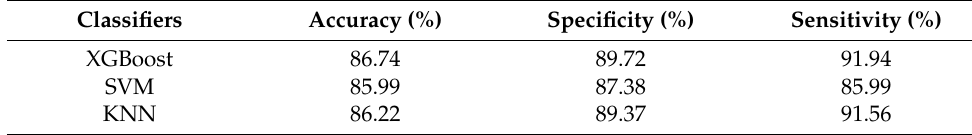
Table 3. Performance